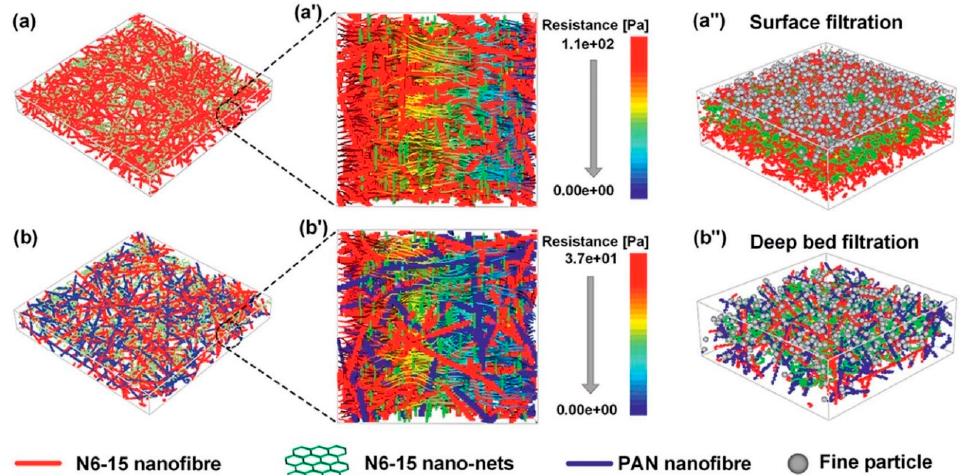
Figure 9. ( a ) 3D N6-15 NFN and ( b ) N6–PAN NNB geometric structures simulated with FibreGeo based on the bulk statistical properties; ( a (cid:48) ) and ( b (cid:48) ) are the airflow resistance distributions in